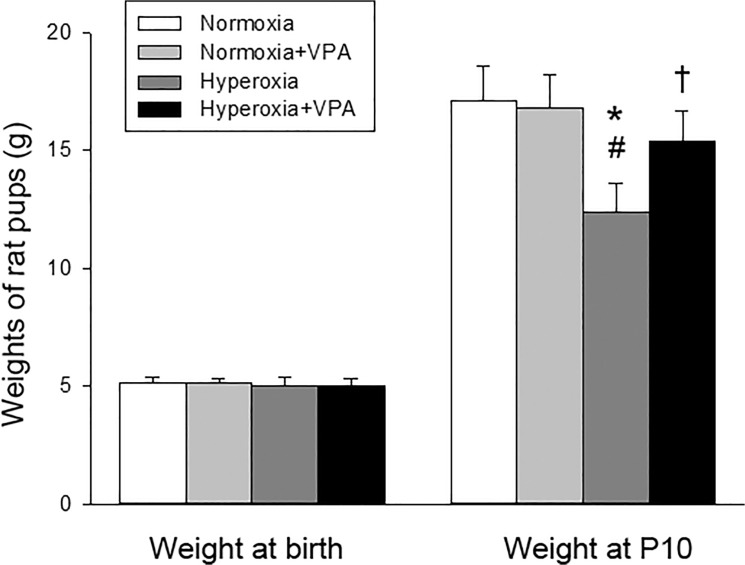
Bar graph depicting body weights of rat pups at birth and P10.*p<0.05 compared to Normoxia group; #p<0.05 compared to Normoxia+VPA group; and †p<0.05 compared to Hyperoxia group using One-Way ANOVA followed by post-hoc Tukey test.